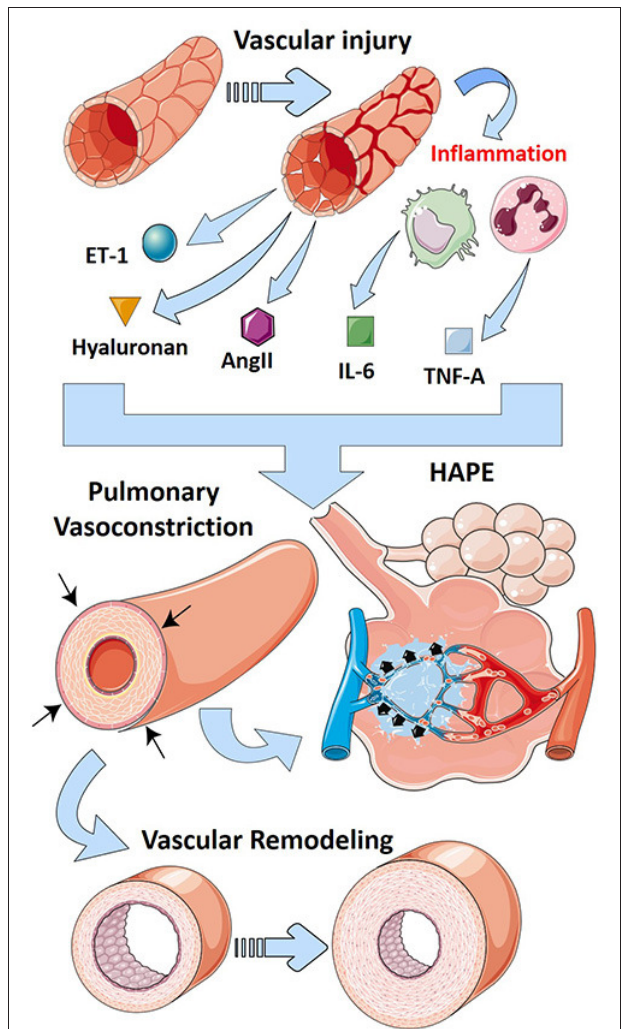
FIGURE 3 | Mechanisms that lead to PH in ARDS. Vascular injury in ARDS leads to the release of vasoactive mediators including endothelin-1 (ET-1-blue/green sphere), hyaluronan (golden triangle), and angiotensin II (AngII, purple hexagon). Further, vascular injury promotes inflammation that releases cytokines such as interleukin-6 (IL-6, green squares) and tumor necrosis factor (TNF)- α (blue squares). These vasoactive mediators and cytokines promote vascular remodeling and pulmonary vasoconstriction, hallmarks of pulmonary hypertension. Prolonged vasoconstriction can then lead to high-altitude pulmonary edema (HAPE), a form of lung injury similar to